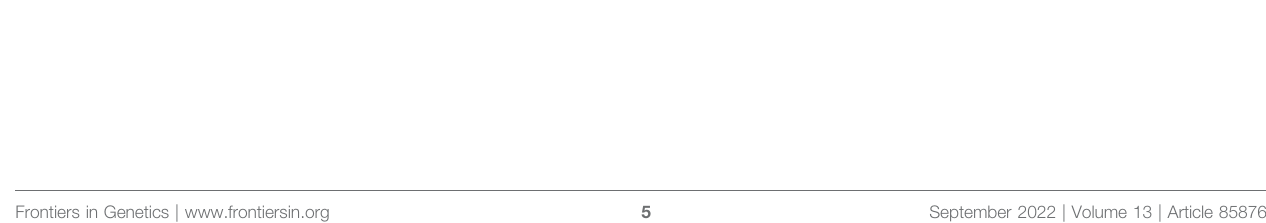
Frontiers in Genetics |